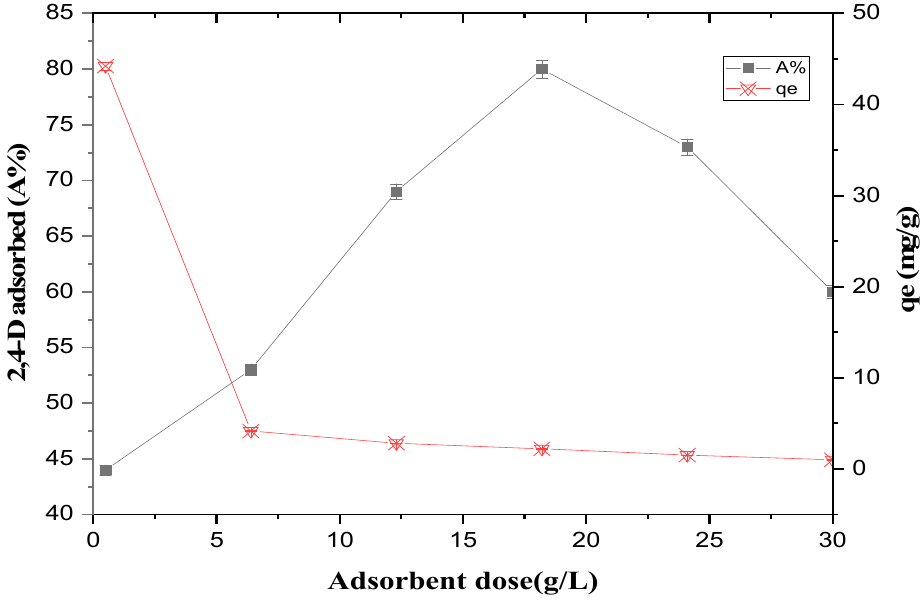
Figure 6. Effect of TMS dose on 2,4-D percentage removal (A%) and adsorption capacity (q e ). The standard deviation for three different sample runs is shown by the error bars.